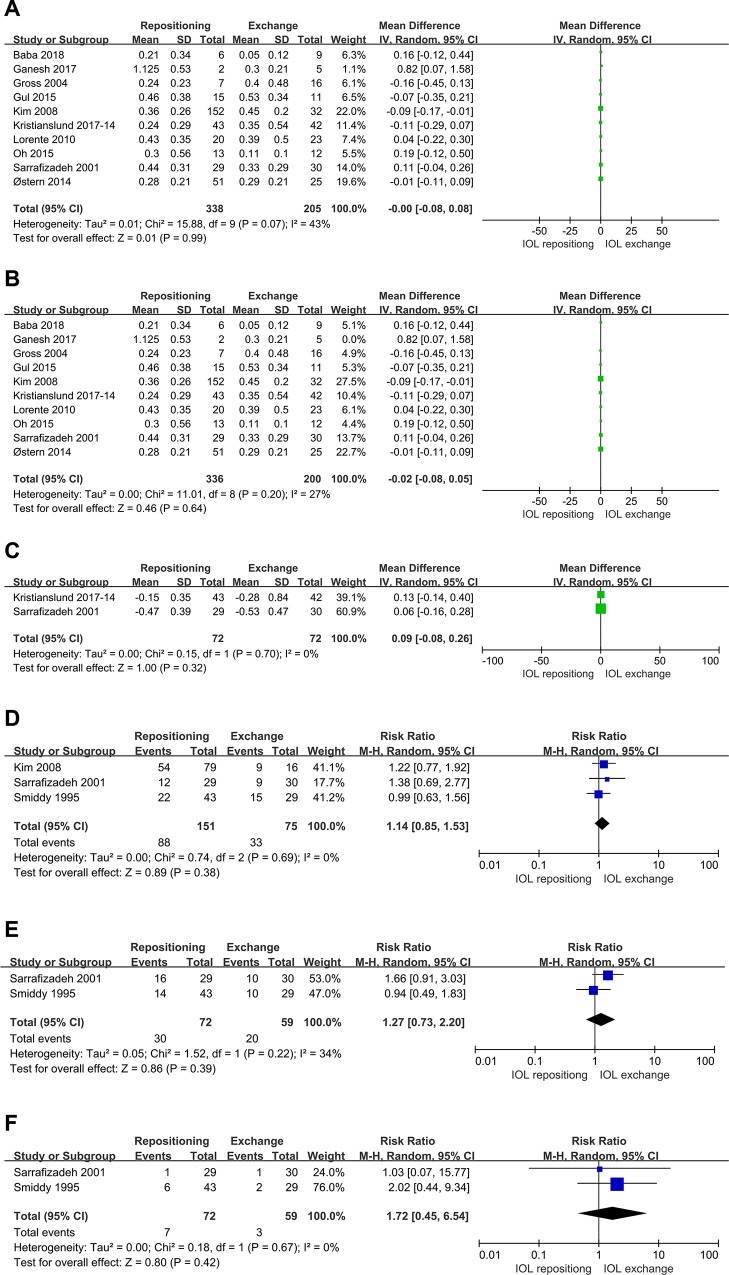
Comparison of IOL repositioning and IOL exchange in terms of BCVA.(A) Postoperative BCVA. (B) Sensitivity analysis of postoperative BCVA, after excluding a small study. (C) Difference between peri- and postoperative BCVA. (D) Incidence of BCVA>20/40. (E) Incidence of BCVA 20/50–20/200. (F) Incidence of BCVA <20/200.